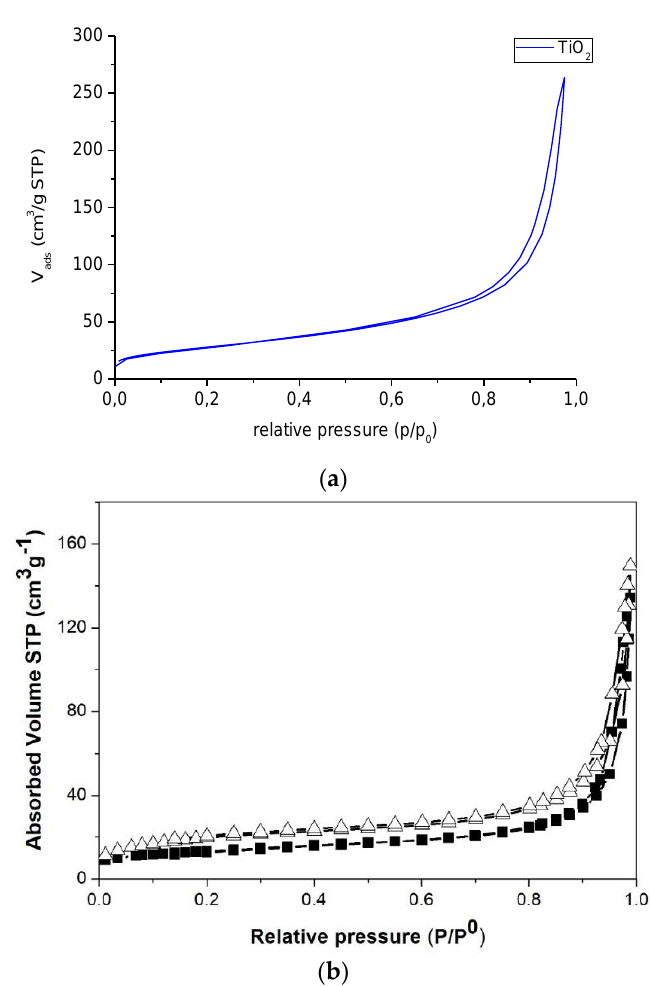
Figure 3. N 2 isotherms at −196 °C of ( a ) PREC and ( b ) P25 (full squares) and FSP (hollow triangles) samples.